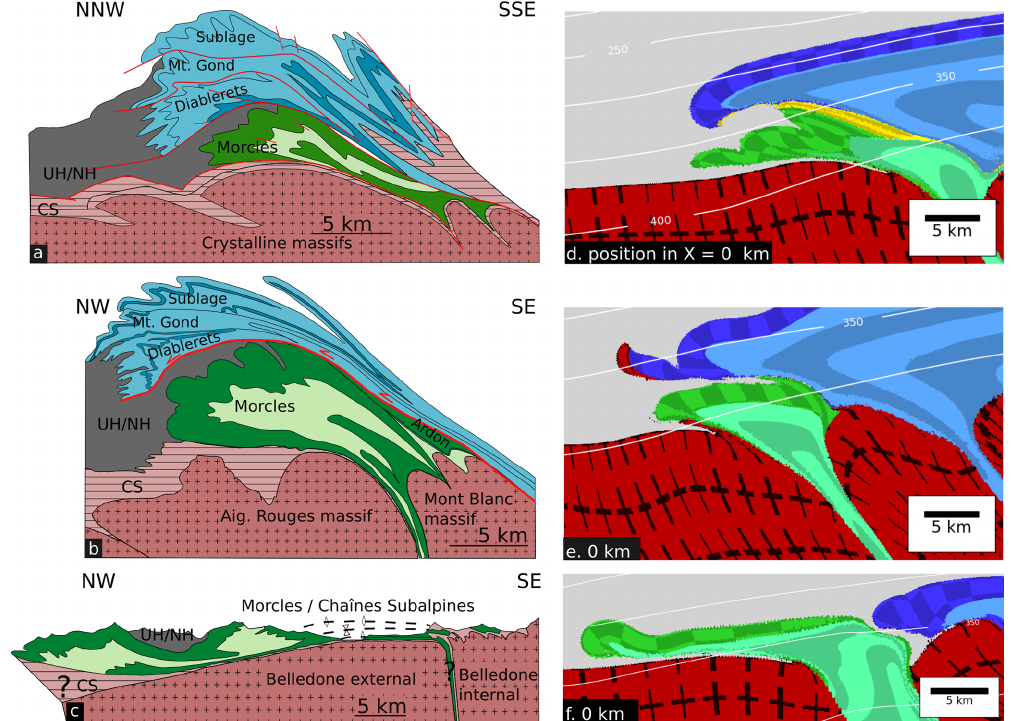
Figure 15. Comparison between selected numerical cross sections and simplified geological cross sections. Row-wise (top to bottom) (a) Simplified Morcles section modified after Pfiffner (2015) (indicated in the map of Fig. 1 with the dashed profile line) and (d) sec- tion from model D.G-1. (b) Simplified Morcles section modified after Escher et al. (1993) and (e) cross-section model F.G-1. (c) Simplified section modified after Epard (1990) and (f) section from model A.G-2. UH/NH = Ultrahelvetics/North Helvetics. CS = Cover